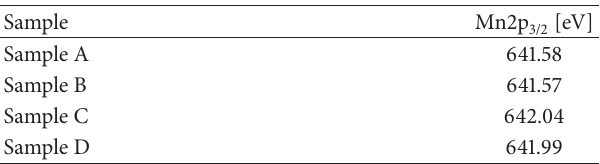
Table 2: Binding energy of Mn2p precursors.